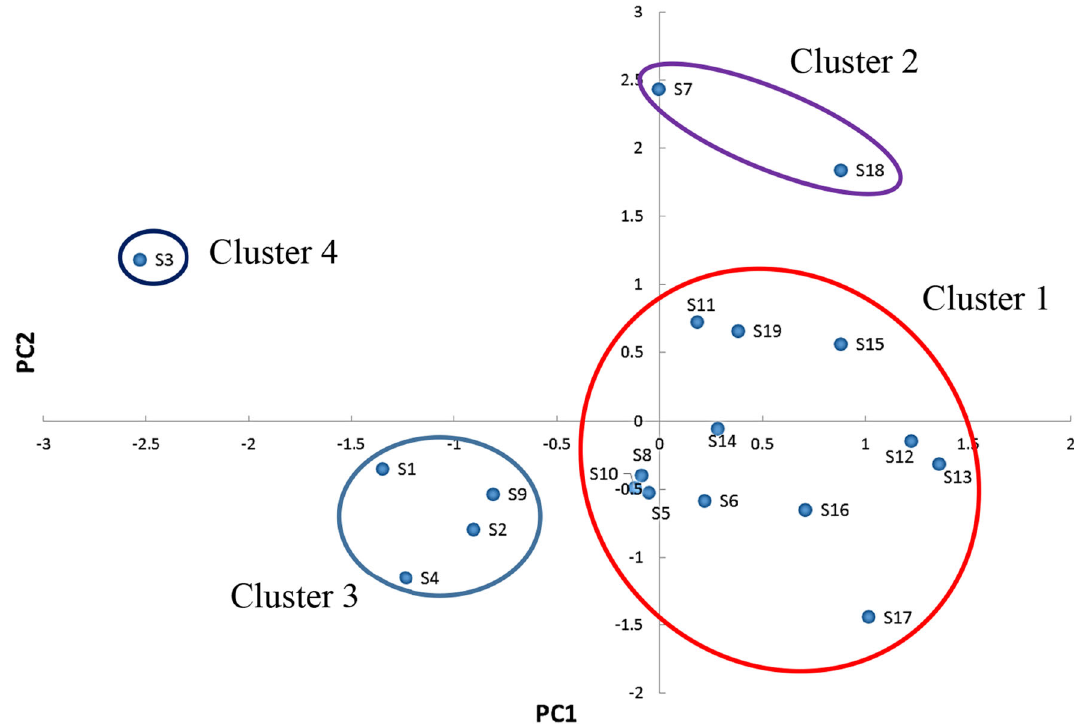
Fig. 9 Plots of PC1 vs. PC2 showing groupings among sampling sites